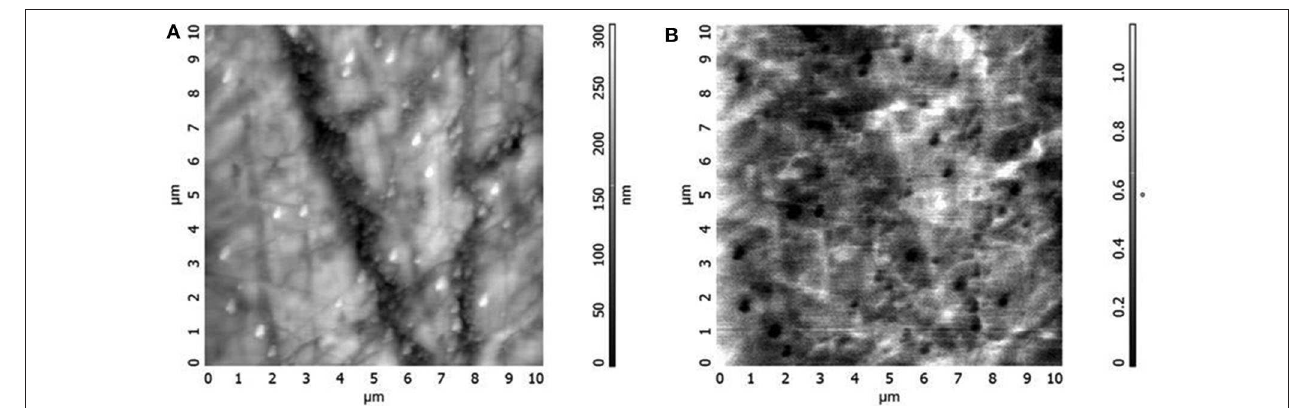
FIGURE 4 | AFM images of topography (A) and magnetic properties (B) on the cross-section of the epoxy coating containing nano-sized nickel ferrite.